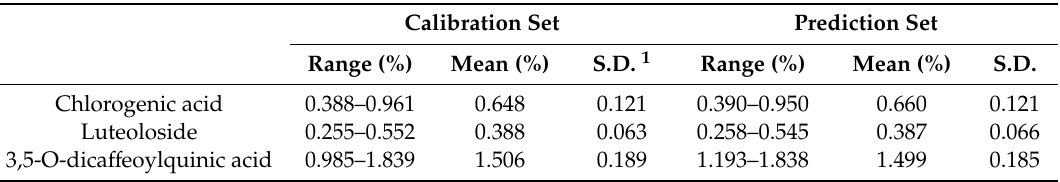
Figure 1. Raw spectra of Chrysanthemum measured by the Matrix Duplex NIR system working in the wavenumber range of 12,000 cm − 1 to 4000 cm − 1 . Table 1. Referent contents of Chlorogenic acid, luteoloside, and 3,5 ‐ O ‐ dicaffeoylquinic acid in Chrysanthemum determined by HPLC.